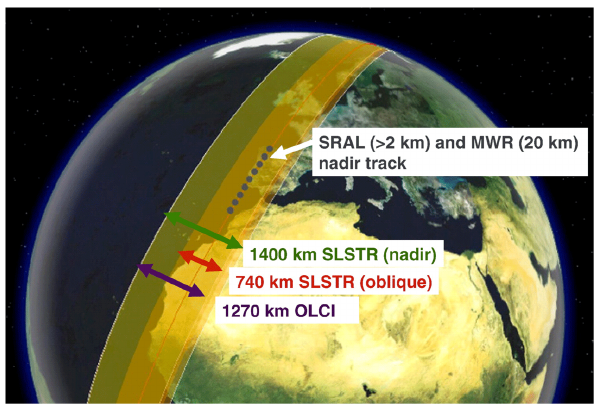
Figure 1. Schematic overview of the Sentinel-3 instrument swaths (courtesy of